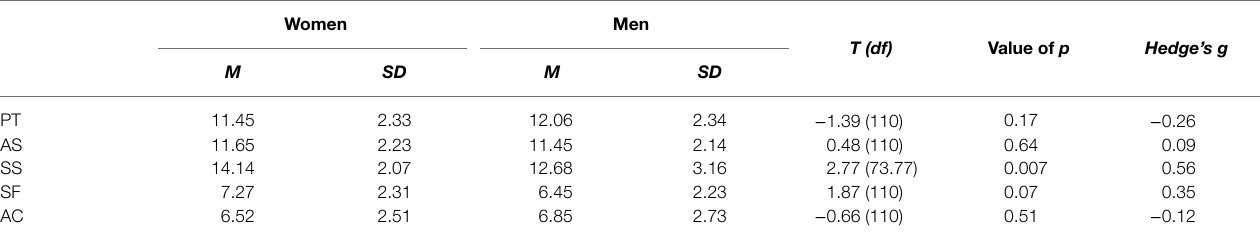
TABLE 8 | Differences in coping styles between women and